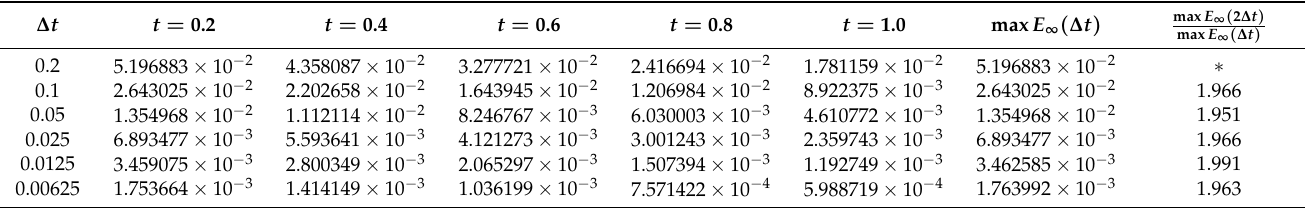
Figure 7. Results of Example 4, ( a ) impact of the number of initial data points (inhomo- geneous term data points, artificially generated data points and delay term data points) on E ∞ ( t n ) , when the backward Euler scheme is employed. Fix ∆ t to be 10 − 1 , max E ∞ ( ∆ t ) = max 1 ≤ n ≤ N 10 − 2 and 10 − 3 in turn. ( b ) Impact of the level of the additive noise on the maximum absolute error E ∞ , when the backward Euler scheme is used. Fix the number of initial data points (inhomogeneous term data points, artificially generated data points and delay term data points) to be 20, and take ∆ t = 0.01. Table 5. Problem of Example 4: maximum absolute error E ∞ at five time nodes for different ∆ t under the backward Euler scheme and the convergence order in